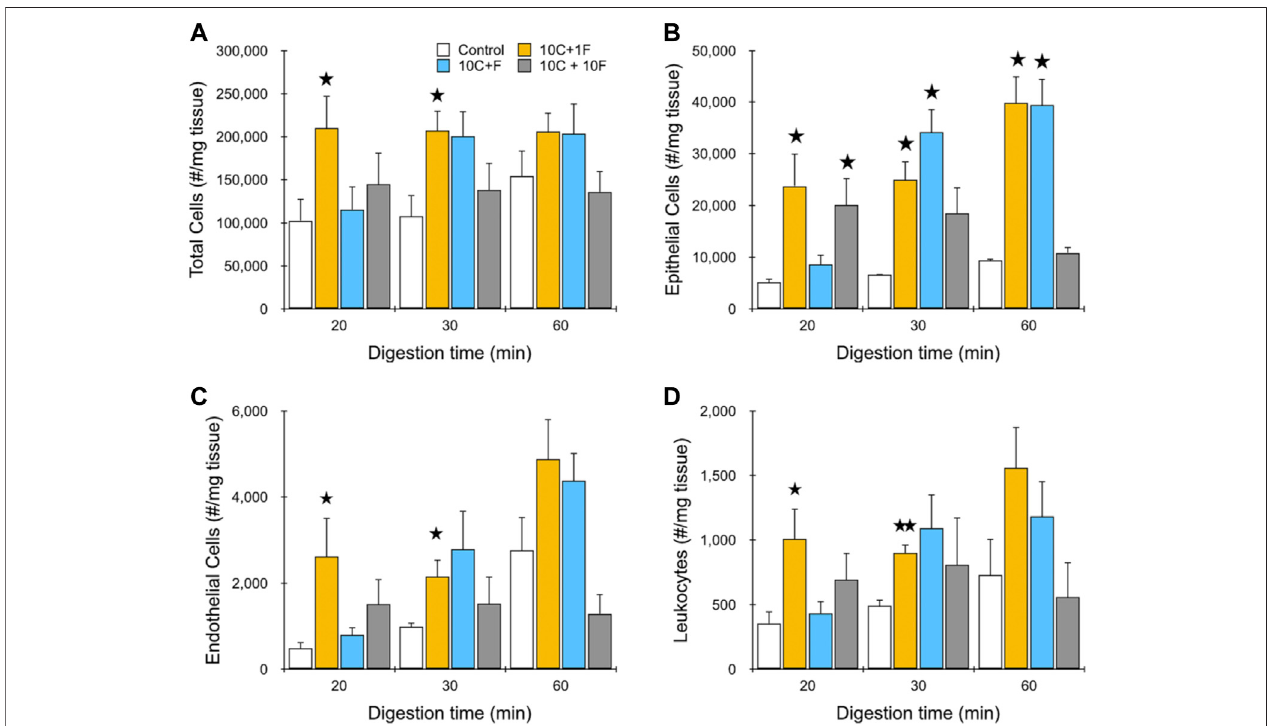
FIGURE 4 | Evaluation of dissociation formats using murine kidney. Kidneys were harvested, minced, and digested for the indicated time periods. Samples were then passed through the channel module 10 times and fi lter module once (10C, 1F), simultaneously through both modules 10 times (10C + F), or sequentially through both modules 10 times (10C + 10F) at 40 ml/min and the resulting cell suspensions were analyzed using fl ow cytometry. Controls were pipetted/vortexed and passed through a cell strainer. Results are shown for viable and single (A) total cells, (B) EpCAM + epithelial cells, (C) endothelial cells, and (D) leukocytes. Optimal results wereattainedusingthesingle fi lterpassateachdigestiontime.Dataarepresentedasmeanvalues±SEMfromatleastthreeindependentexperiments.Two-sided t test was used for statistical testing. Stars indicate p < .05 and double stars indicate p < .01 relative to the control at the same digestion